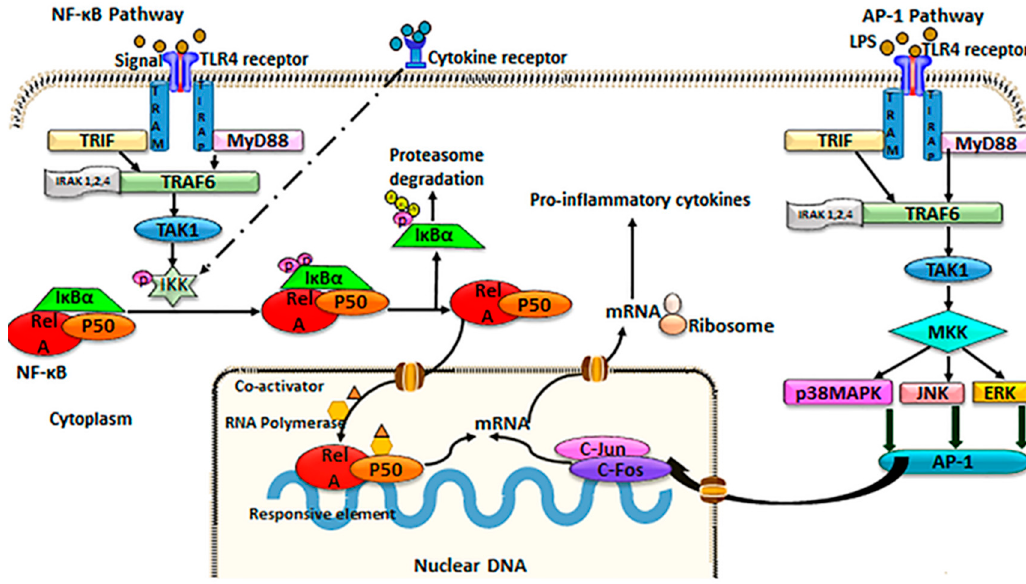
Figure 1. Schematic of TLR4/NF ‐κ B/AP ‐ 1 signaling.